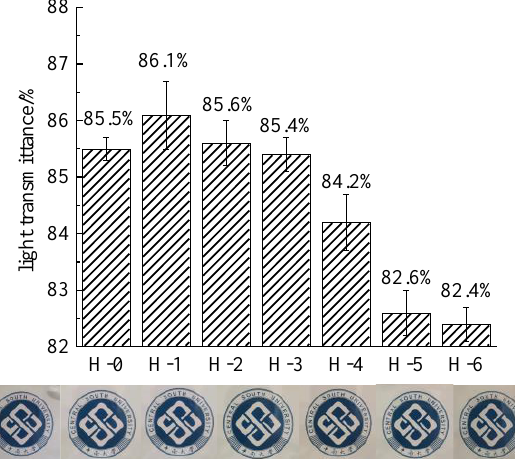
Figure 4. Visible light transmittance of fire-resistant glass samples.